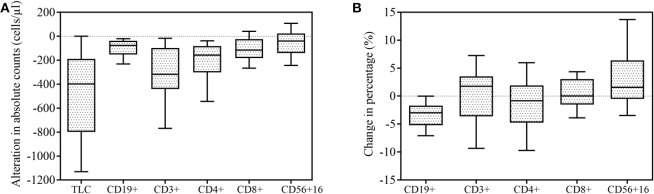
Effect of stereotactic body radiation therapy (SBRT) on peripheral lymphocyte counts (n = 76) and lymphocyte subsets (n = 55). All box-and-whisker plots show median (middle horizontal line), 75th percentile (top horizontal line), 25th percentile (bottom horizontal line), 90th percentile (top whisker), and 10th percentile (bottom whisker) for change in lymphocyte and lymphocyte subsets following SBRT. (A) Alteration in absolute counts of lymphocytes and lymphocyte subsets. (B) Percentage change in lymphocyte subsets.